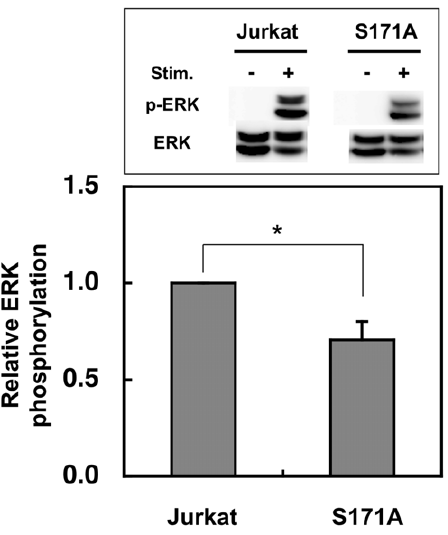
Figure 7. Overexpression of GFP-SET-S171A reduced the ERK activation after stimulation. Normal and GFP-SET-S171A-overex- pressing Jurkat cells were stimulated by anti-CD3e antibody and anti- mouse IgG antibody for 7 min were lyzed and subjected to SDS-PAGE followed by the western blot analyses. The phospho-ERK (p-ERK) was first detected and quantified and after stripping off the antibodies, ERK1 was detected and quantified to monitor p-ERK/ERK1 ratio. The p-ERK/ ERK1 ratio of Jurkat cell was assigned to be 1. The results were indicated as mean + SD for three independent experiments. *, p , 0.01, as determined by Student’s t